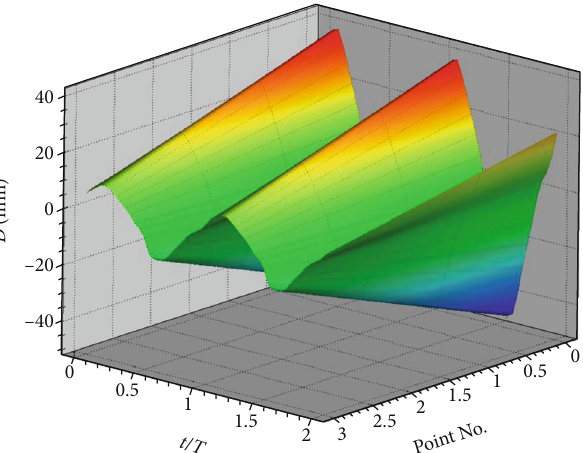
Figure 15: Deformation of four points on the rib of the wing tip relative to point 4.